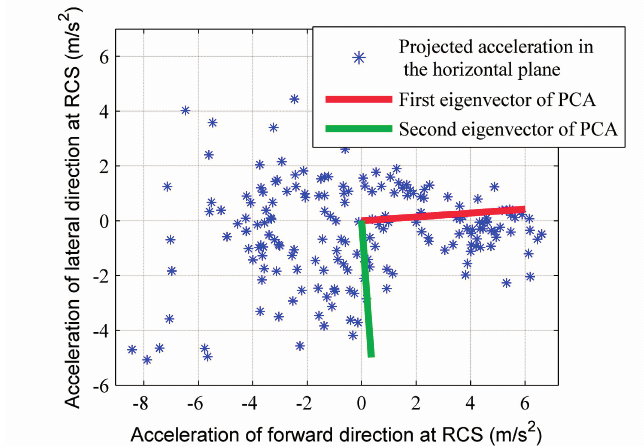
Figure 3. Illustration of PCA for eigenvector extraction over the horizontal plane of acceleration signals to infer the local walking direction at RCS.